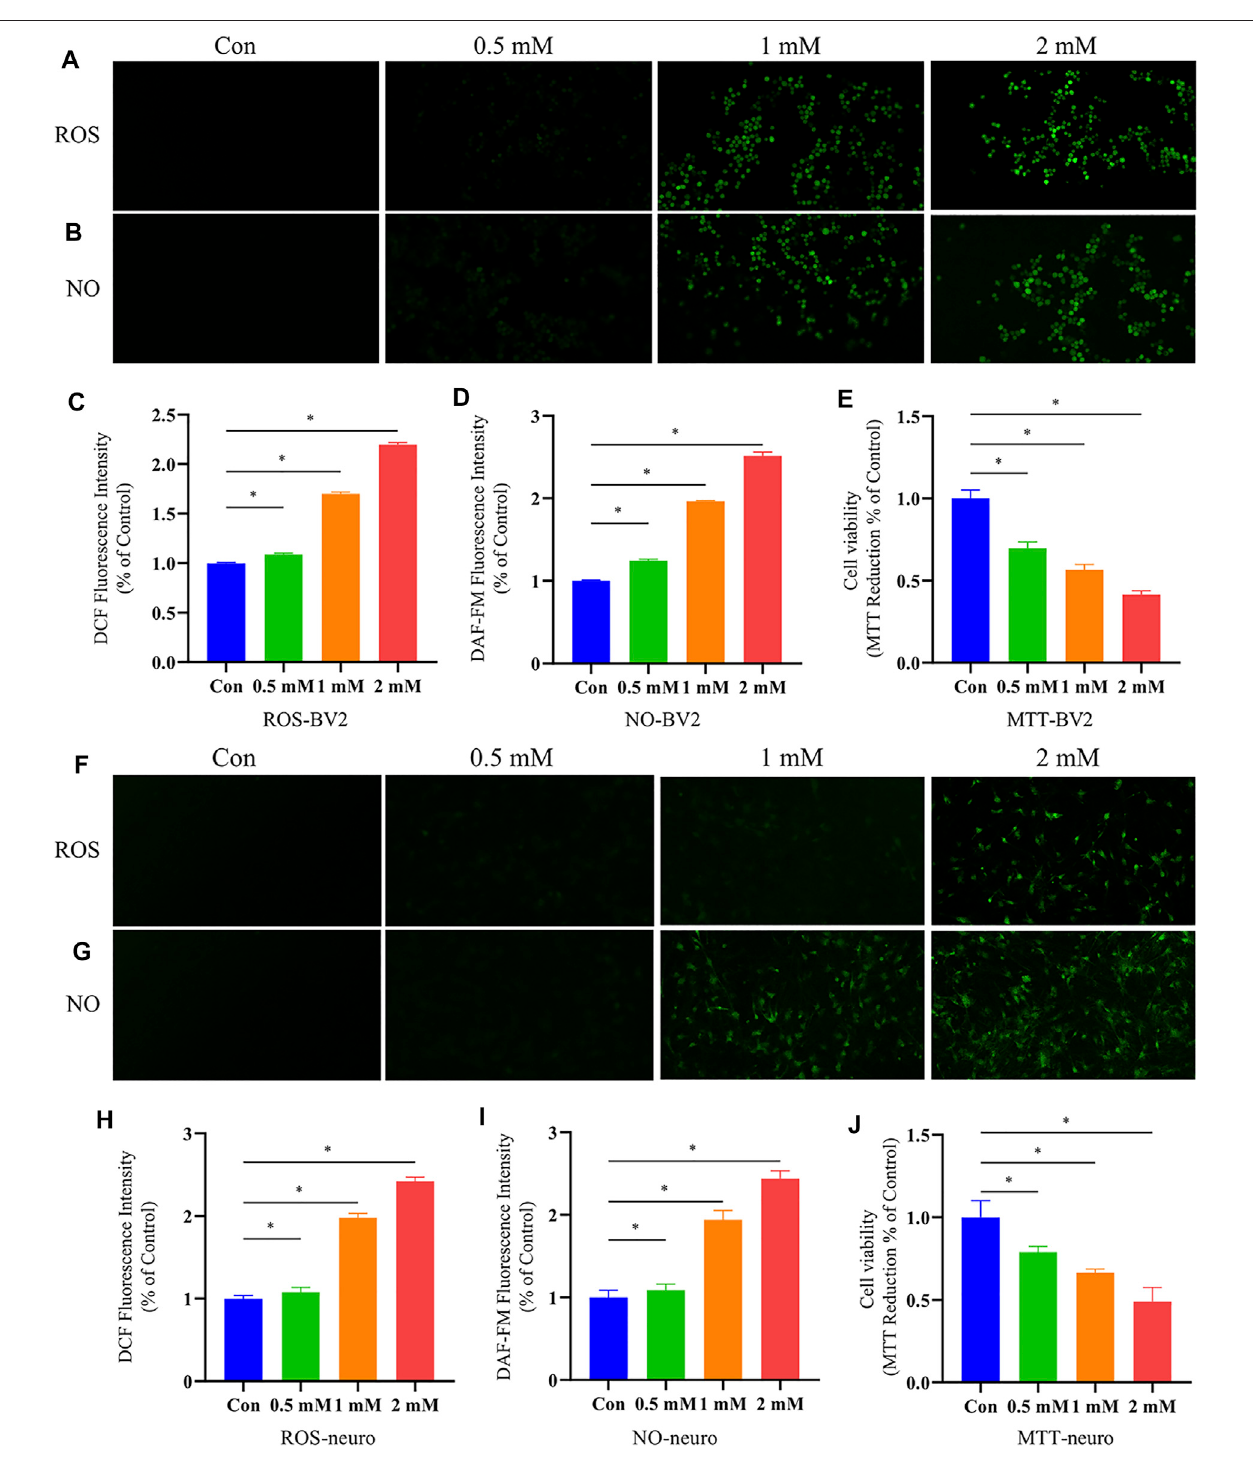
FIGURE 8 | Effects of o -tyr on oxidative stress and cell viability of BV-2 and neurons. (A,B) Fluorescent images of ROS (A) and NO (B) in BV-2 cells, with in situ signalsquanti fi edin (C) and (D) . (E) Effectof o -tyrontheviabilityofBV-2cells. (F,G) FluorescentimagesofROS (F) andNO (G) inBV-2cells,with insitu signalsquanti fi ed in (H) and (I) . (J) Effect of o -tyr on the viability of neuronal cells. Values are expressed as the mean ± S.E.M.; n (cid:1) 6; * p < 0.05 versus Con, by Student ’ s unpaired t -test.